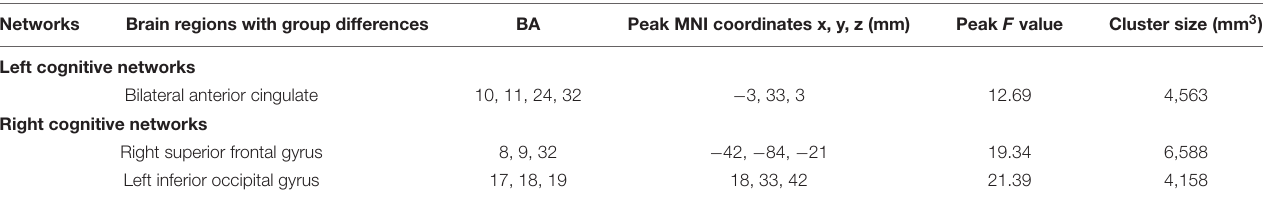
TABLE 2 | Interactions between disease and cognitive